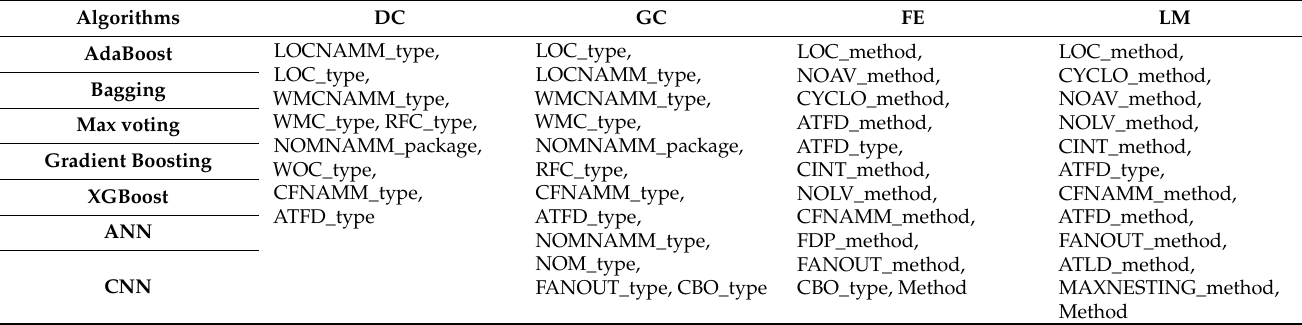
Table A1. Best feature of each method.